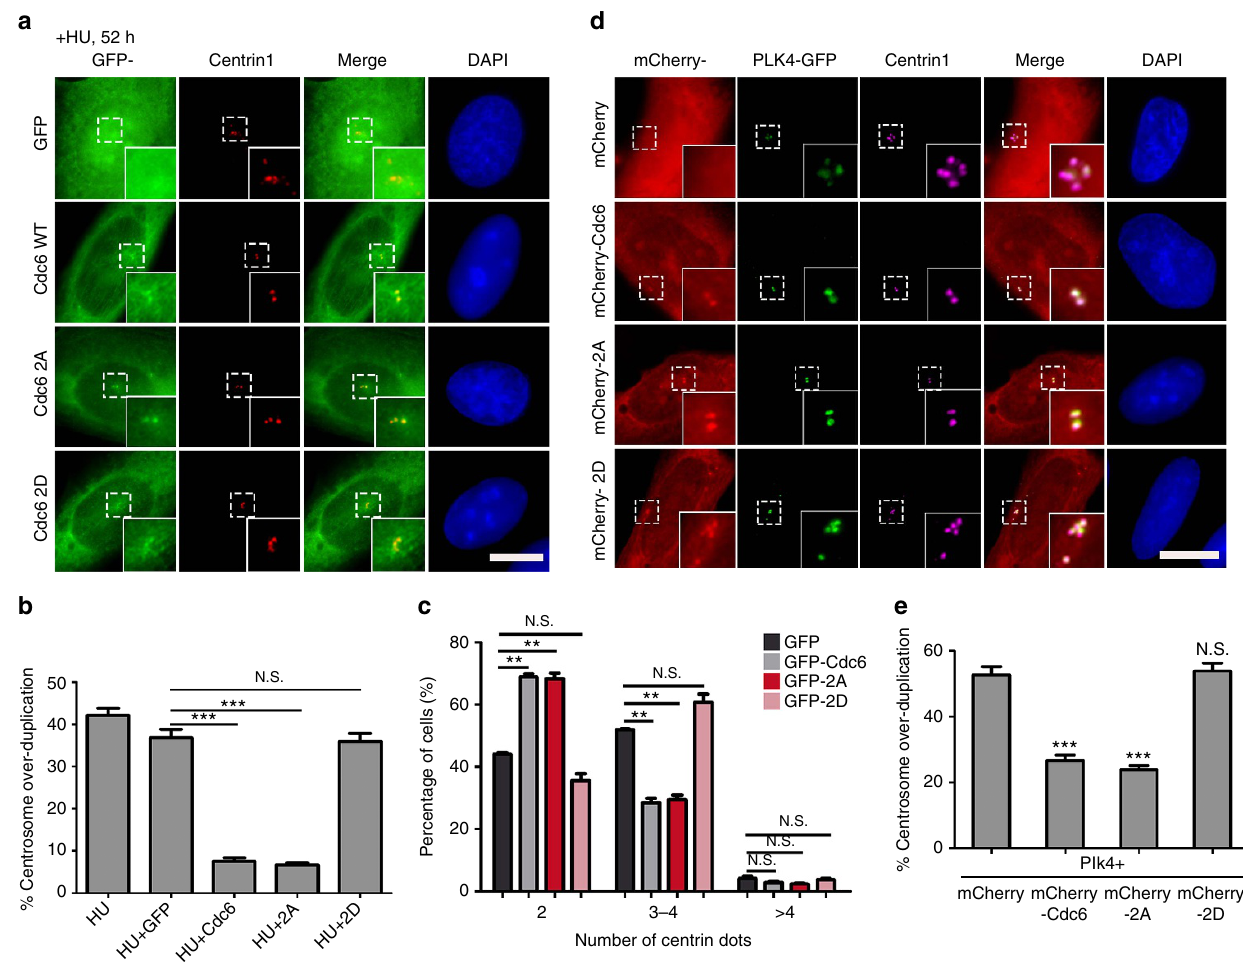
Figure 5 | Phosphorylation of Cdc6 by Plk4 abolishes the inhibitory role of Cdc6 on centrosome duplication. ( a ) Cdc6 WTor 2A mutant, but not 2D mutant, inhibits HU-induced centrosome over-duplication. U2OS cells were transfected with GFP, GFP-tagged Cdc6 WT, GFP-tagged Cdc6 2A or 2D mutant, and treated with 16mM HU for 52h to allow centriole amplification. The cells were then stained with a centrin1 antibody. ( b ) Quantitation of cells with 4 4 centrioles in a . Approximately 100 cells were counted per sample, and three independent experiments were conducted. ( c ) Overexpression of Cdc6 WTor 2A mutant, but not 2D mutant, inhibits the centrosome duplication during the cell cycle. U2OS cells were transfected with GFP, GFP-tagged Cdc6 WTand GFP-tagged Cdc6 2A or 2D mutant for 50h. The cells were then stained with a centrin1 antibody. The number of centrin1-positive dots in transfected cells was counted. Approximately 300 cells were counted per sample, and three independent experiments were conducted. ( d ) Overexpression of Cdc6 WT or 2A mutant, but not 2D mutant, suppresses Plk4-induced centriole amplification. U2OS cells were transfected with GFP-tagged Plk4 and mCherry-tagged Cdc6 WT, 2A or 2D mutant for 40h. The cells were then stained with a centrin1 antibody. ( e ) Quantitation of cells with 4 4 centrioles in d . Approximately 100 cells were counted per sample, and three independent experiments were conducted. The statistical data in b , c and e are presented as means ± s.d. ** P o 0.01, and *** P o 0.001; N.S., no significant difference (Student’s t -test). DNA was stained with DAPI. Scale bars, 10 m m. Insets in a and d are high-magnification views of the regions indicated in the low-magnification